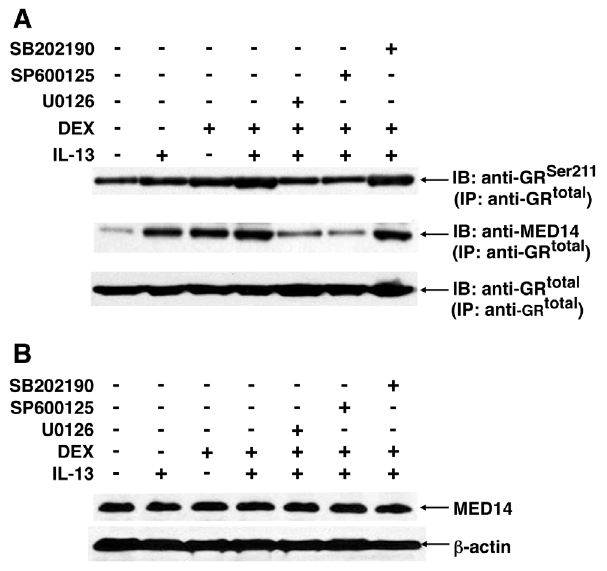
Figure 7. Enhanced DEX-induced co-localization of p-GR Ser211 and the transcriptional co-factor, MED14, in IL-13-exposed HASM cells is prevented by inhibition of ERK1/2 and JNK signaling. ( A ) Representative co-immunoprecipitation study demon- strating increased co-localization of both phosphorylated GR Ser211 and MED14, detected by immunoblotting (IB), with immunoprecipitated (IP) GR in nuclear extracts from HASM cells exposed to either IL-13 or DEX alone. The latter co-localiztion is further enhanced in IL-13 + DEX-treated cells, and is largely suppressed by pretreating the cells with either the ERK1/2 or JNK inhibitor, whereas the p38 MAPK inhibitor has no effect. ( B ) Note: The above effects elicited under the different treatment conditions are detected in the absence of any corresponding change